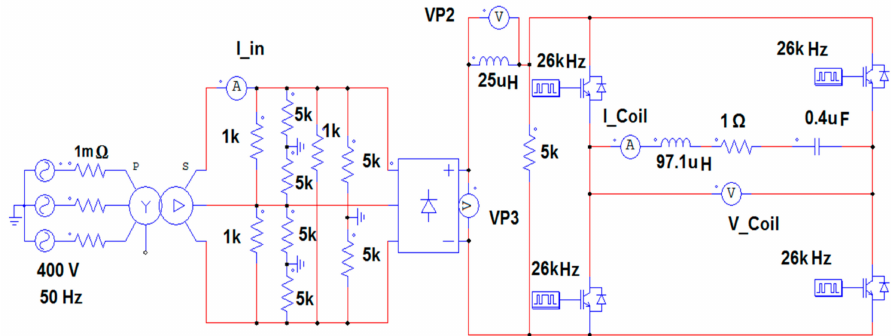
Figure 6. Simulation circuit diagram of the IH equipment without an LPF.